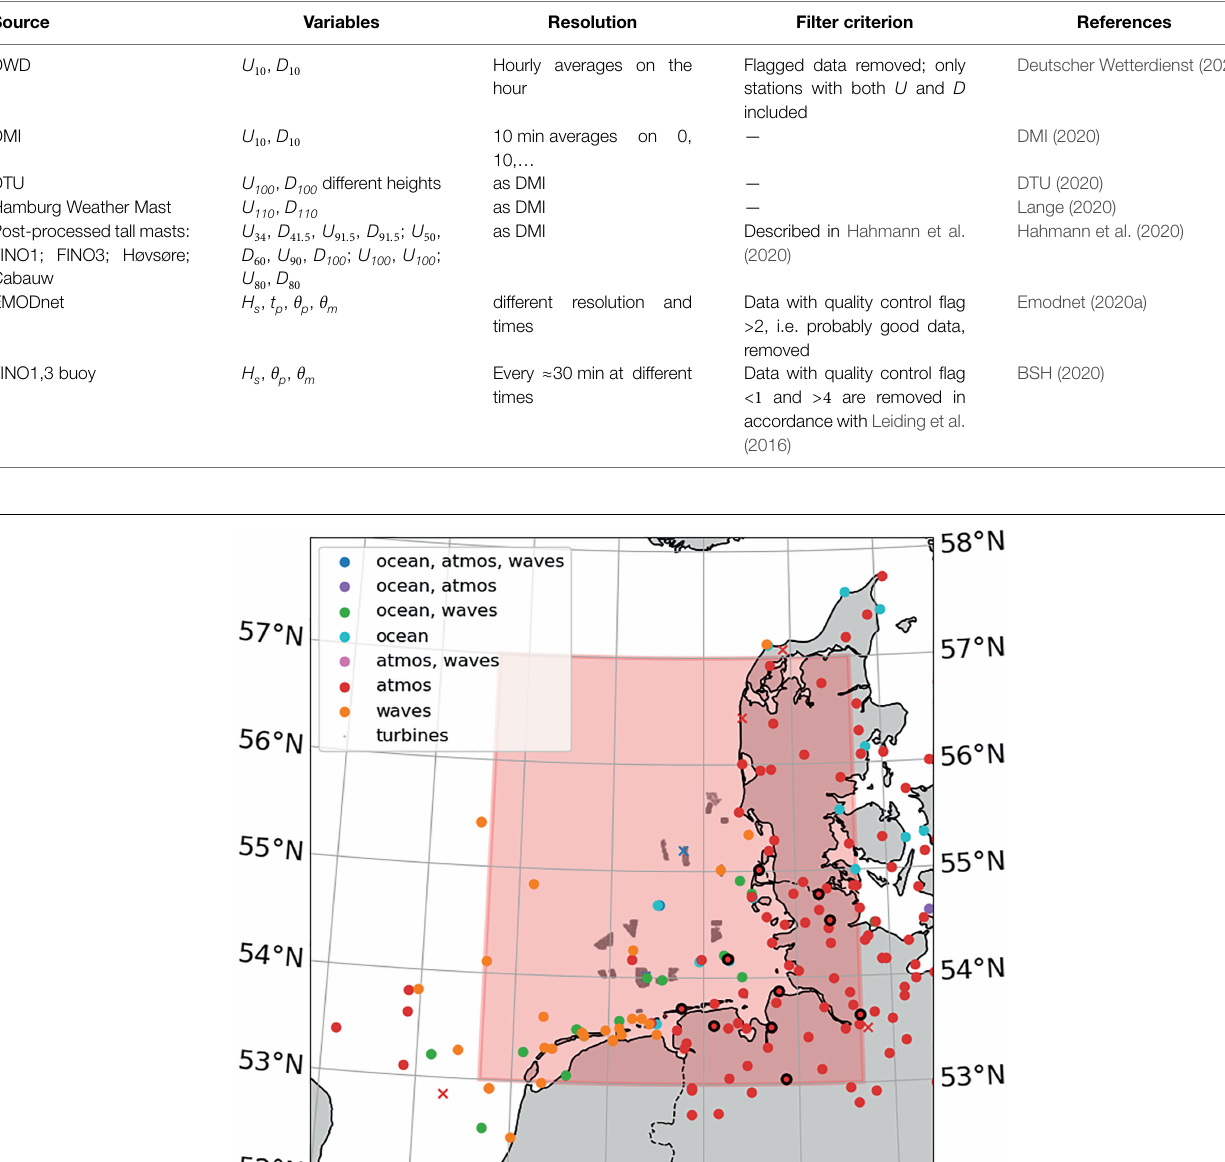
detected using the IOOS (Integrated Ocean Observing System) QARTOD (Quality Assurance/Quality Control of Real-Time Oceanographic Data) method (IOOS, 2021). After the automatic checks, a manual visual quality control is